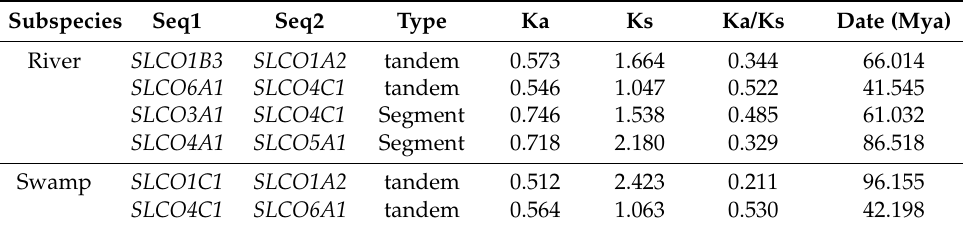
Figure 2. Gene duplication of river and swamp buffalo OAT genes ( A ) and their collinear analysis ( B ) . The tandem duplicated genes are marked by a red line, and segmentally duplicated genes are indicated by “#.” Table 2. The Ka/Ks ratios and divergence times for each pair of duplicated OAT genes in buffalo subspecies.